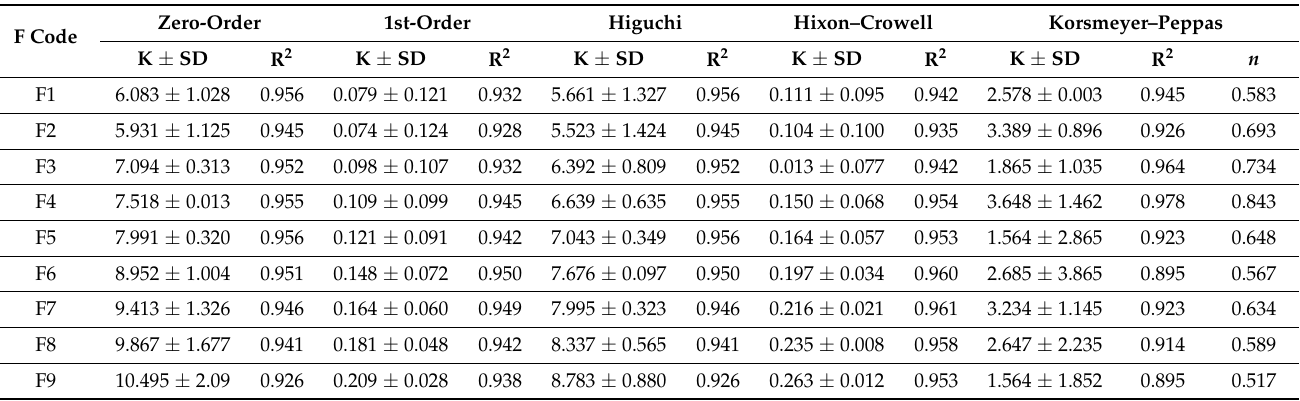
Table 4. Regression parameters of various formulations after fitting the drug release data to various release kinetic models.